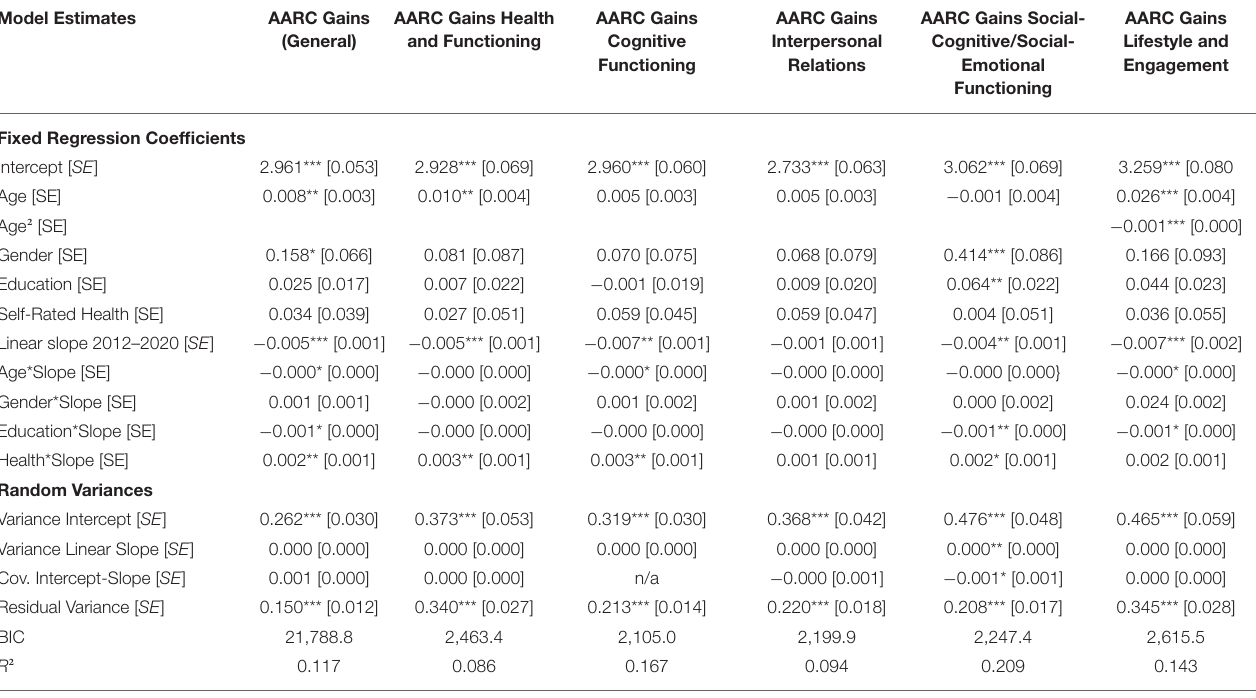
TABLE 1 | Longitudinal multilevel regression models of changes in AARC